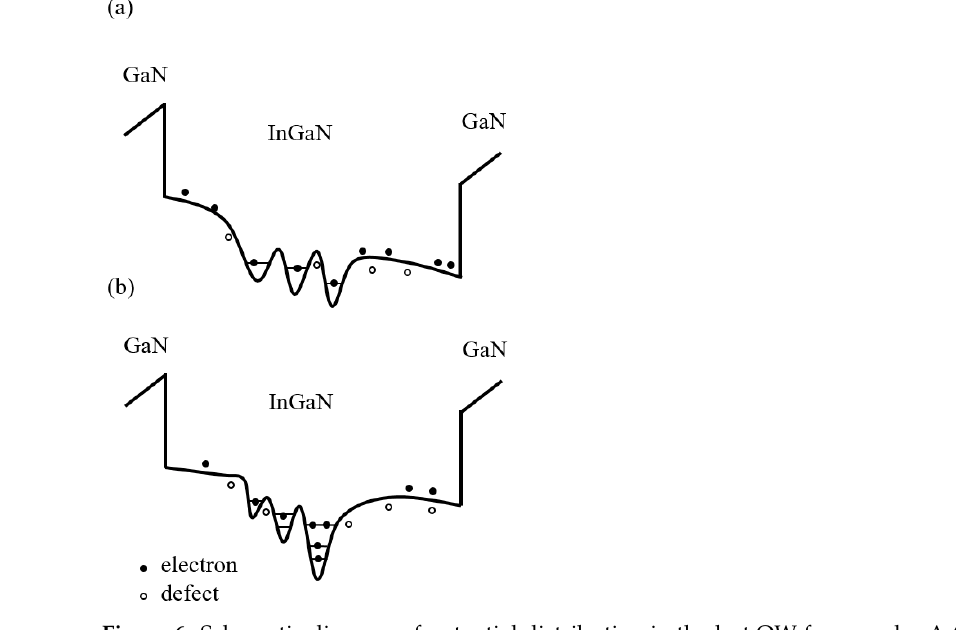
Figure 6. Schematic diagram of potential distribution in the last QW for samples A (a) and B (b), indicating the possible mechanism of carrier dynamics in the QW structure.